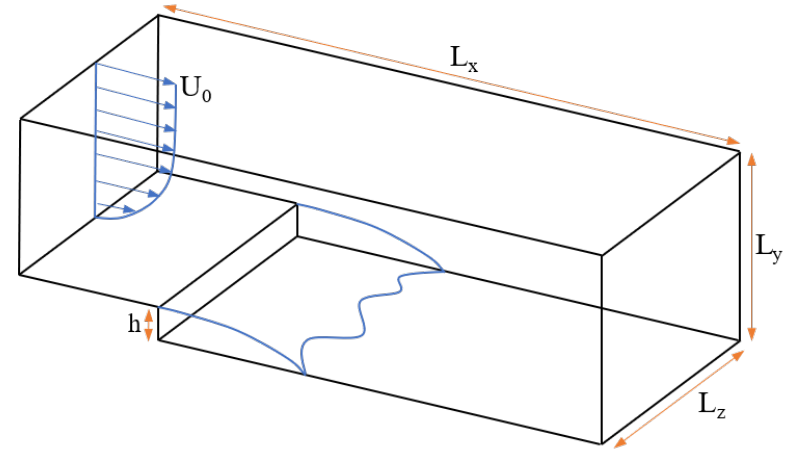
Figure 5. Three-dimensional computational domain.